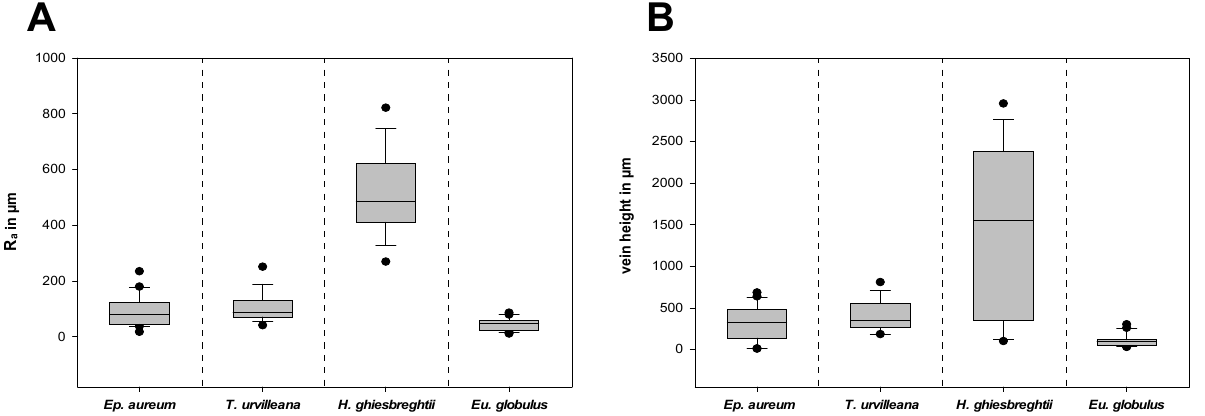
Figure 9. Characterization of the surface texture of the leaves. ( A ) Arithmetical mean roughness R a and ( B ) vein height. n = 17 ( T. urvilleana ), 18 ( H. ghiesbreghtii ), 20 ( Ep. aureum , Eu. globulus ) for both ( A , B) . The boxes indicate 25th and 75th percentiles, whiskers define the 10th and 90th percentiles and the line within the boxes represents the median. Outliers are shown as individual